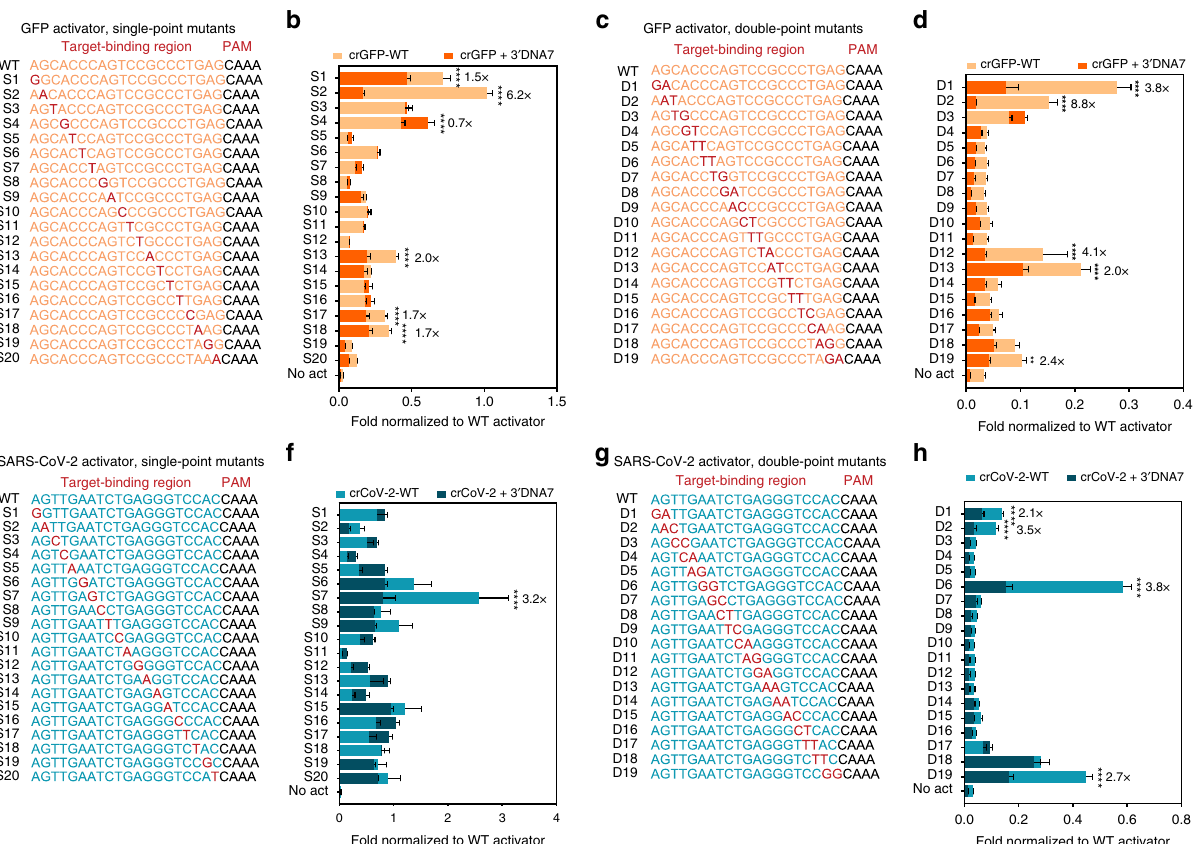
Fig. 4 Improved speci fi city of LbCas12a trans-cleavage with ENHANCE. a Single-point mutations (S1-S20) and c double-point mutations (D1-D19) on the target strand of a dsDNA GFP activator. b Superimposed bar graphs indicating fold change in fl uorescence of the S1-S20 mutant GFP activators normalized to the corresponding wild-type activator a . d Superimposed bar graphs indicating fold change in fl uorescence of the D1-D19 mutant GFP activators normalized to the corresponding wild-type activator in c . e Single-point mutations (S1-S20) and g double-point mutations (D1-D19) on the target strand